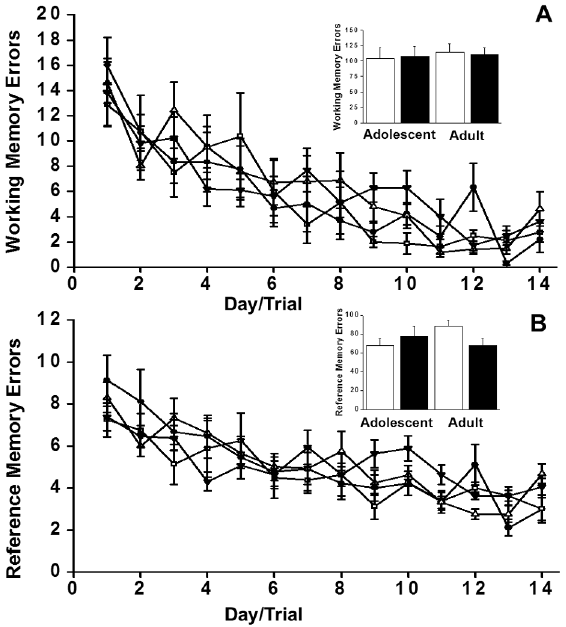
N Figure 1. Effects of chronic intermittent ethanol ( and . ) or saline ( % and n ) exposure during adolescence or adulthood (respectively), on working memory (panel A) and reference memory (panel B) over the 1st 14 days of training in the initial ‘Win-Shift’ phase of RAM testing. The number of working memory (p , 0.05) and reference memory (p , 0.05) errors decreased across days. The effect of Age and Pre-Treatment were not significant. The histogram insets illustrate the overall effect (i.e., cumulative over all sessions) of ethanol (black bars) and saline (white bars) on working (panel C) and reference (panel D) memory errors. Data are expressed as means 6 SEM (n=9 adolescent saline, n=9 adolescent CIE, n=8 young- adult saline, n=8 young-adult CIE, n=8 adult saline, n=8 adult CIE).